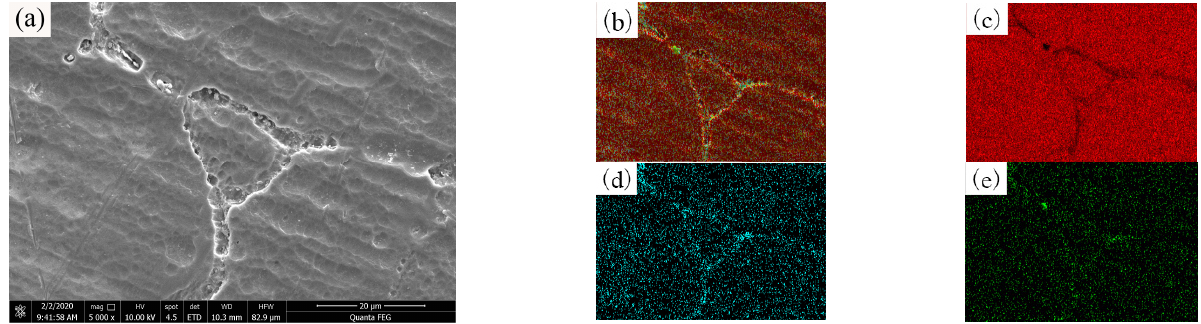
Figure 10. SEM/EDS images for OABs of aluminum alloy wires with a 160 A overcurrent: ( a ) SEM image; ( b ) total element mapping; ( c ) Al mapping; ( d ) Fe mapping; ( e ) Si mapping.